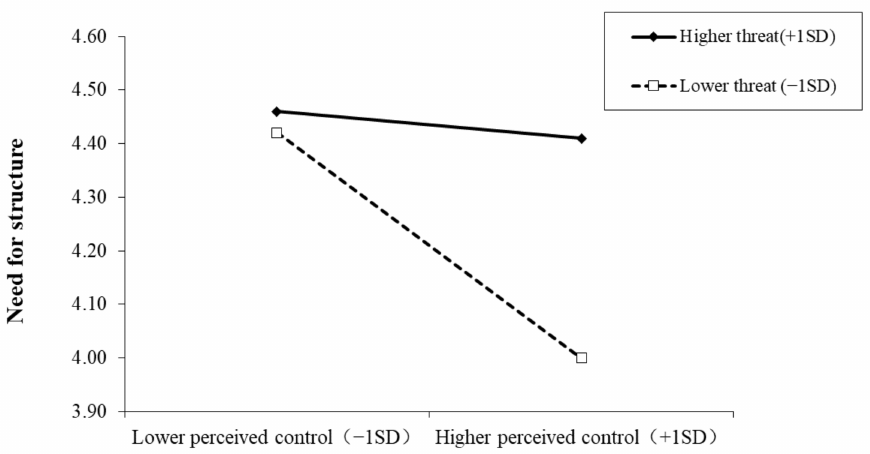
Figure 4. Interactive effect of pandemic threat and perceived control on need for structure. Note: Pandemic threat is graphed for two levels: higher pandemic threat (1 SD above the mean) and lower pandemic threat (1 SD below the